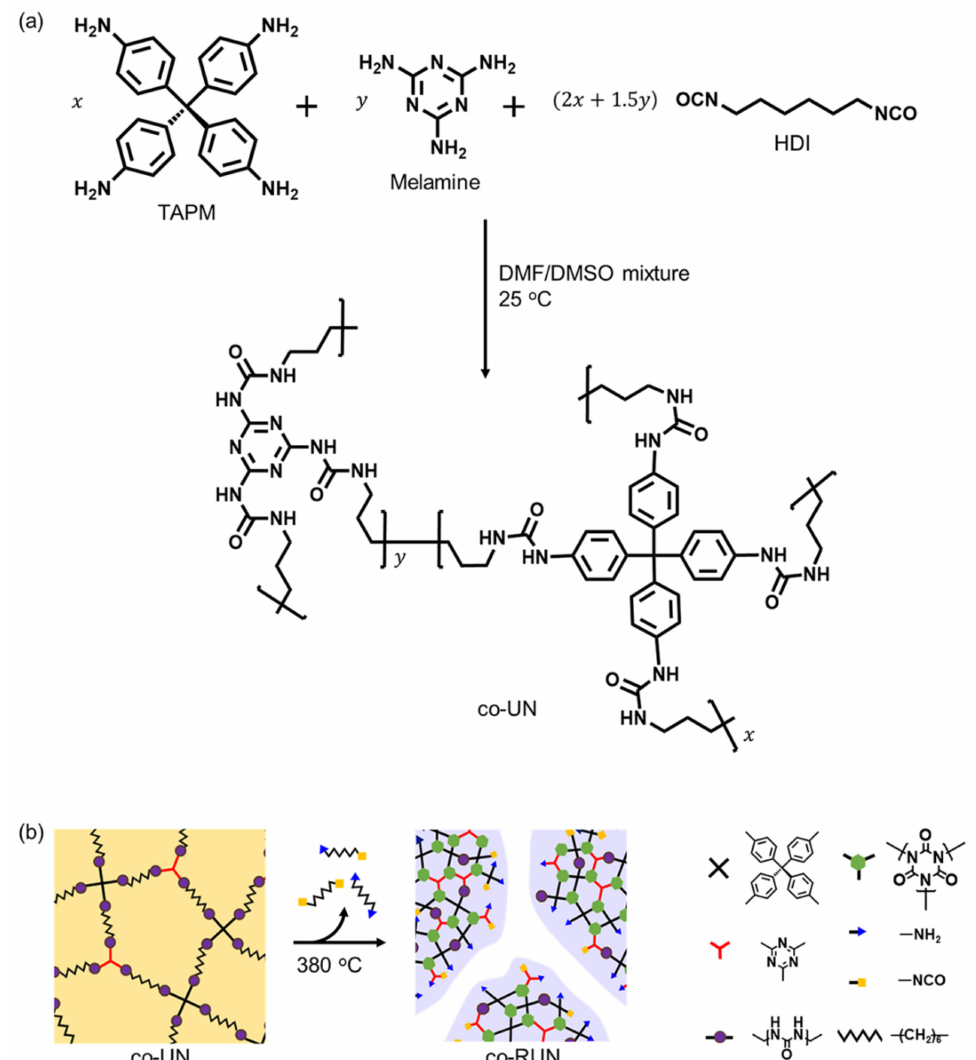
Figure 1. Synthesis of a copolyurea network (co-UN) and its thermal transformation into a rearranged copolyurea network (co-RUN). ( a ) Polymerization of TAPM, melamine, and HDI to obtain a co-UN. ( b ) Schematic illustration of the thermal rearrangement of a co-UN into a microporous